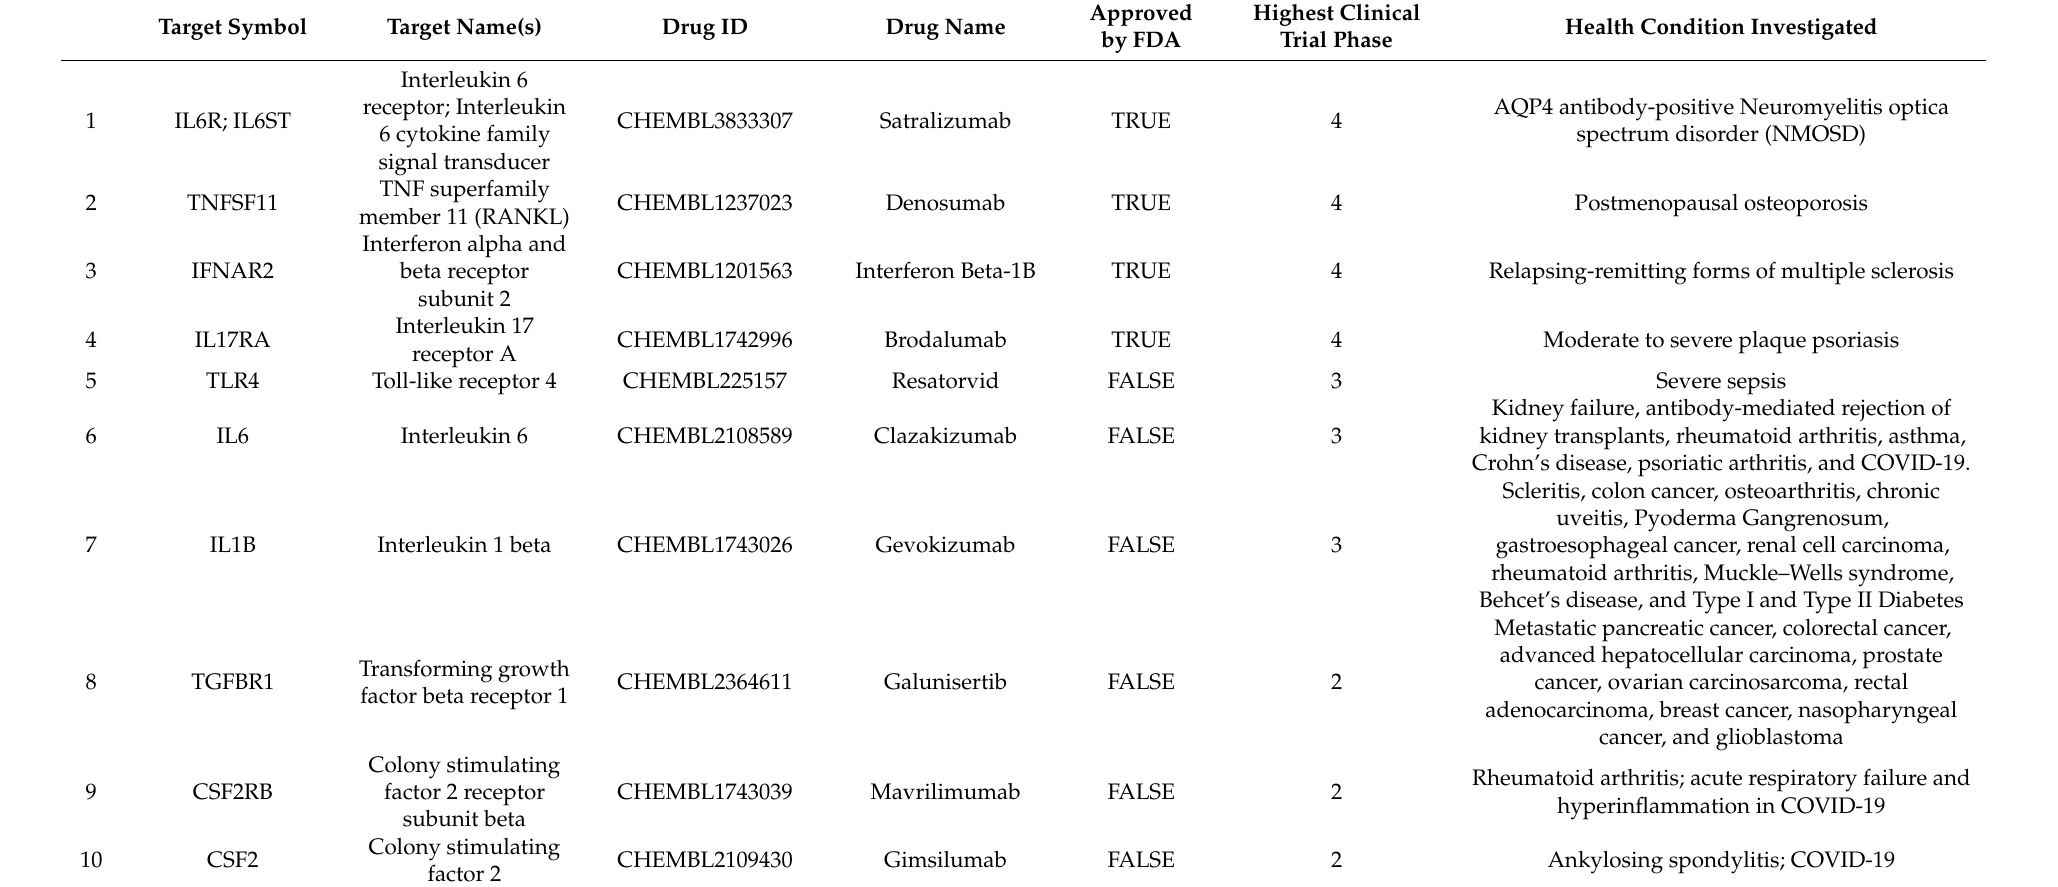
Table 4. List of top 10 drug